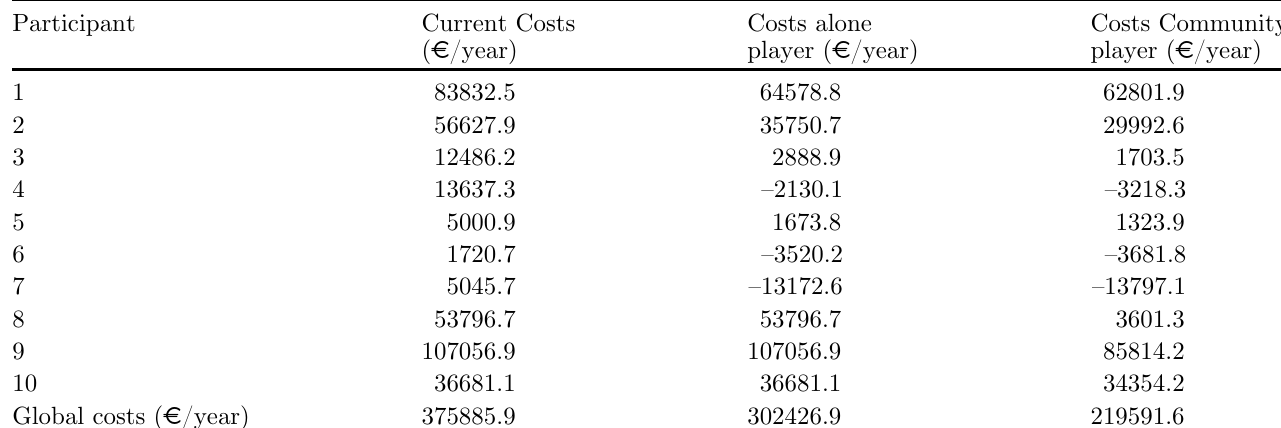
Table 3. Summary of